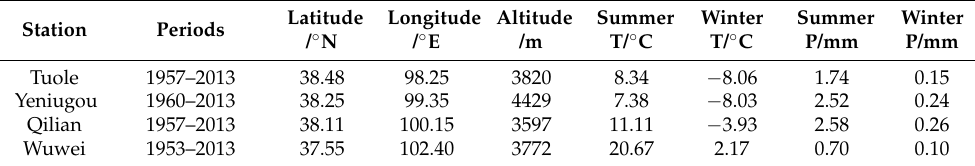
Table 1. The meteorological stations used in this